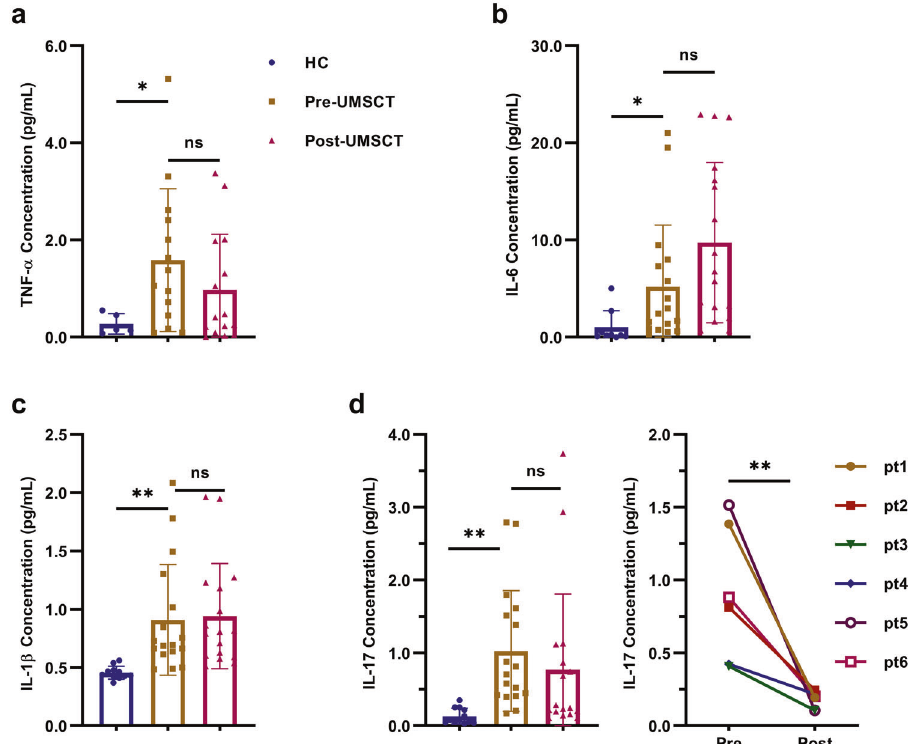
Fig. 5 The in fl ammatory factors in the serum in HC and psoriasis patients pre- and post-UMSCT. a Serum TNF- α concentration. b Serum IL-6 concentration. c Serum IL-1 β concentration. d Serum IL-17 concentration in HC, all psoriasis patients and responders pre- and post-UMSCT.